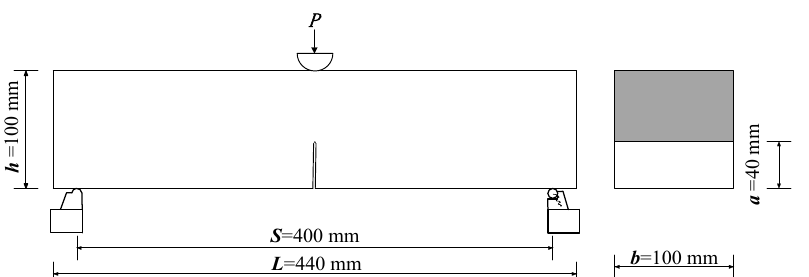
Figure 2. The specific dimensions of the test specimen section. Note: a is the depth of the notch (40 mm), b is the thickness of the test specimen (100 mm), S is the net span of the test specimen (400 mm), L is the length of the test specimen (440 mm), h is the height of the test specimen (100 mm), P is the applied load (kN).